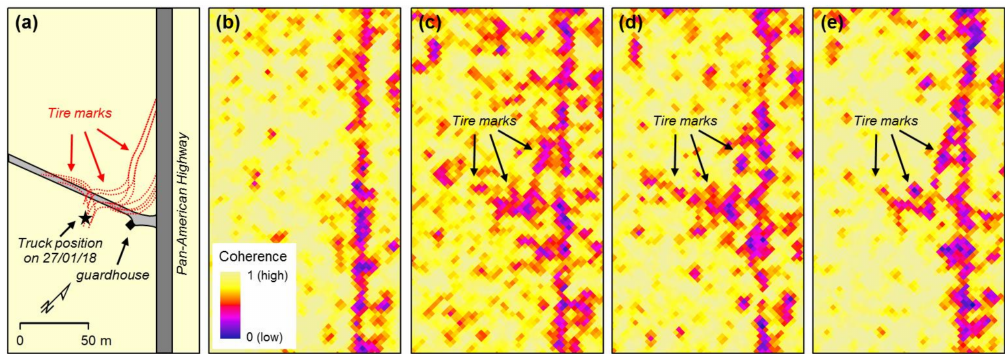
Figure 4. ( a ) Sketch of the tire marks left by the truck on 27/01/2018 (as inferred based on photographic evidence in [22,23]), with indication of the position of the truck during the incident (black star; as inferred based on the video in [24]); and ( b – e ) InSAR coherence γ for the